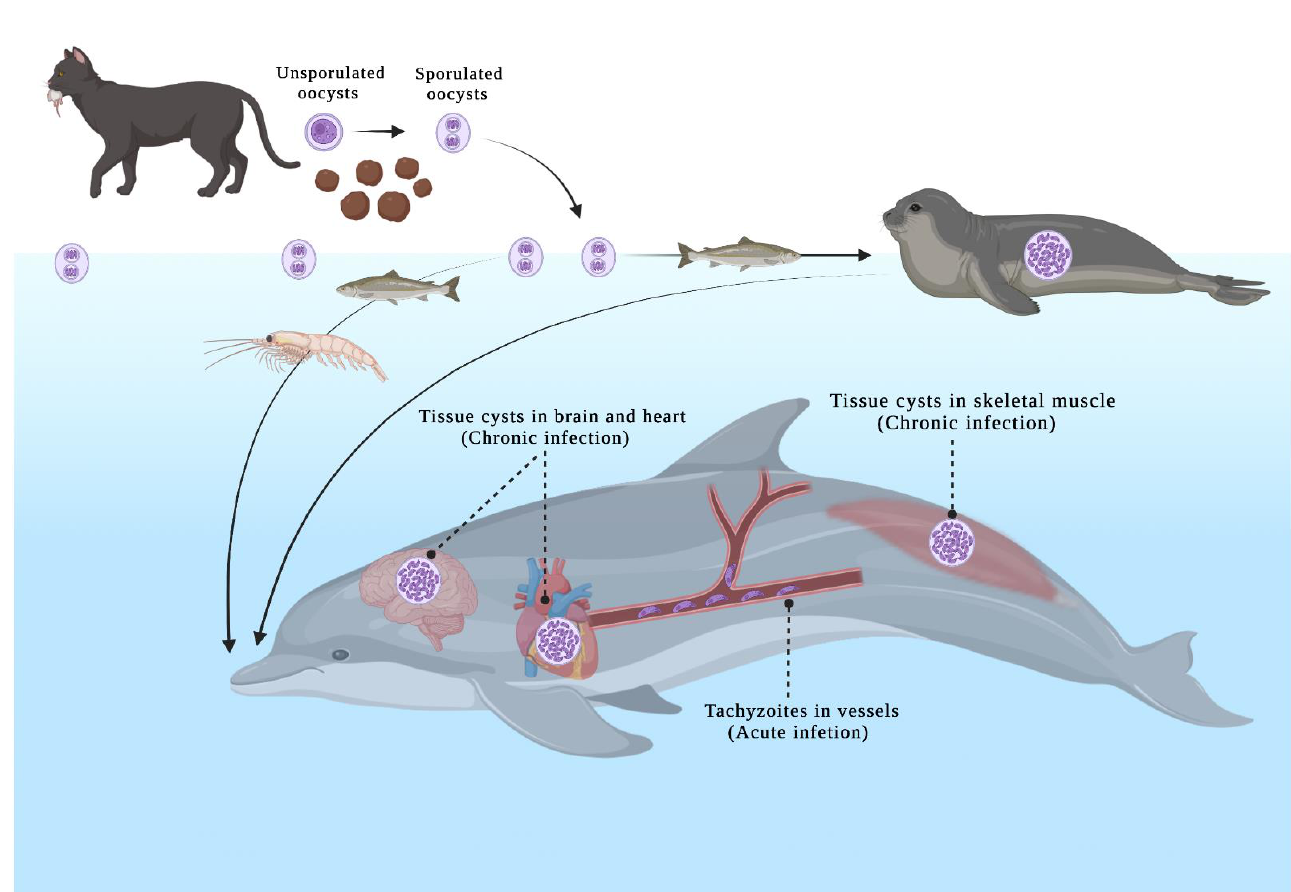
Figure 5. The asexual stage of T. gondii in cetaceans after ingesting oocysts or tissue cysts. Unsporulated oocysts are shed in the cat’s feces, and take 1–5 days to sporulate in the environment and become infective. The invertebrates or filter-feeding fish can harbor the oocysts in the pelagic environment. Table 1. T. gondii or T. gondii -like protozoan parasite exposure in cetaceans [27,31 – 34].